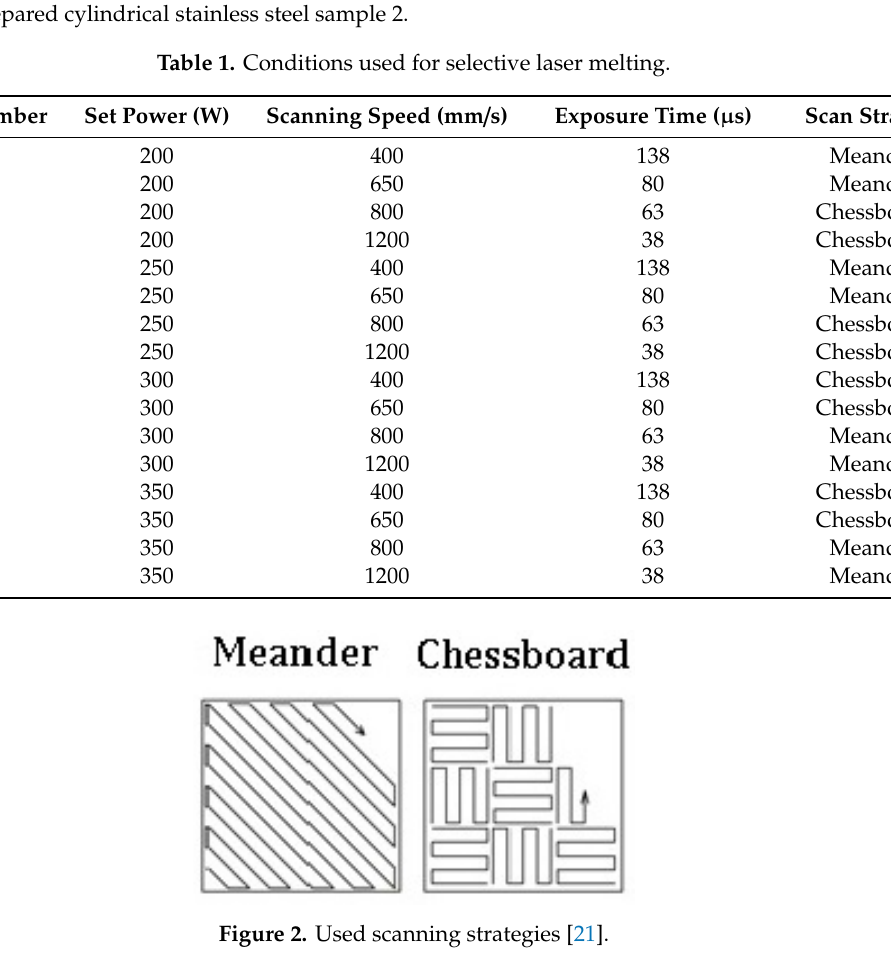
Table 1. Conditions used for selective laser melting.